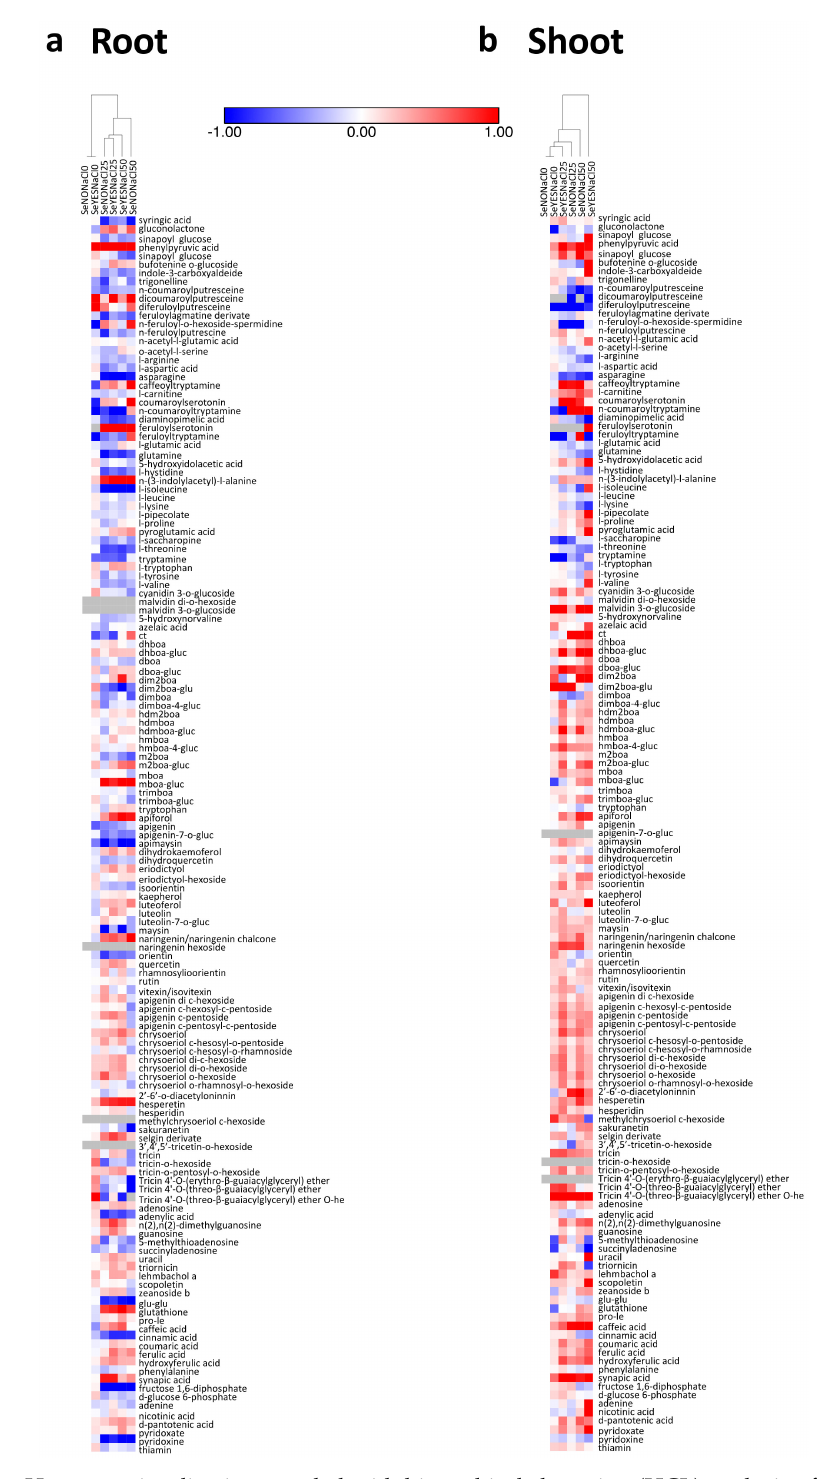
Figure 3. Heatmap visualization coupled with hierarchical clustering (HCL) analysis of semipolar metabolomes in the root ( a ) and shoot ( b ). Data are reported as log2 fold with respect to the Se NO NaCl 0 condition. Only significant metabolites in at least one comparison (treatment vs. Se NO NaCl 0 ), according to a Student t-test (with p -value < 0.05), are reported. Red and shades of red color indicate over-represented metabolites, whilst blue and shades of blue color indicate down-represented metabolites. Data characterized by no alteration in metabolite accumulation are shown in white. Grey boxes indicate metabolites that were not